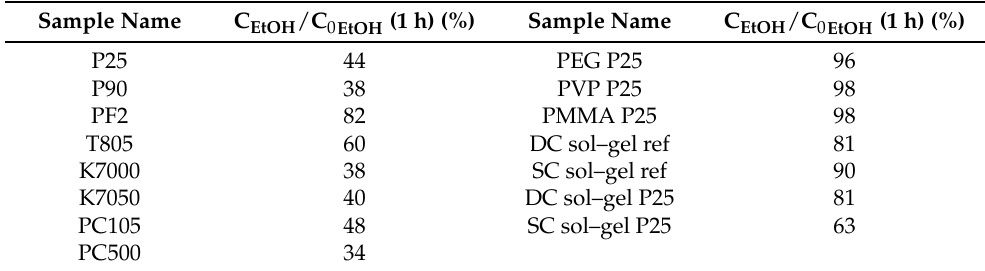
Table 3. Percentage of normalized ethanol concentration, relative to the initial ethanol concentra- tion, after 1 h of photocatalytic degradation for the different TiO 2 samples discussed in this work. An absolute error for these values was estimated to